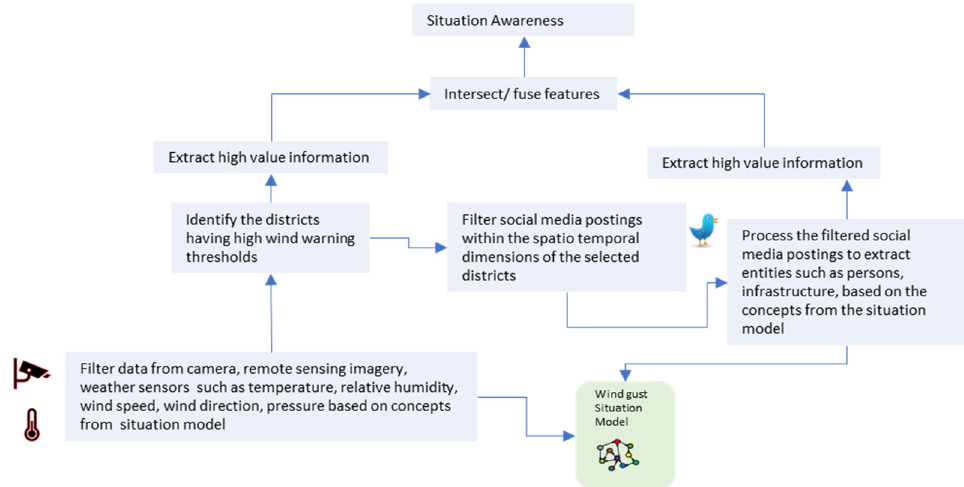
Figure 1. Illustration of data analysis tasks for intersecting sensor and social media data to improve situation awareness .